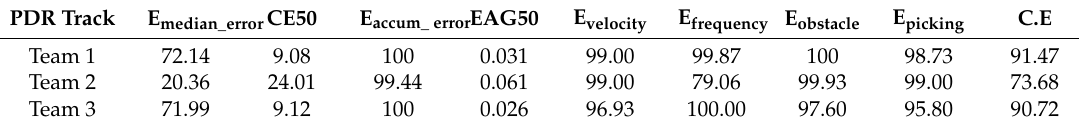
Table 5. Final scores for the evaluation of the xDR Challenge 2018 (PDR track).